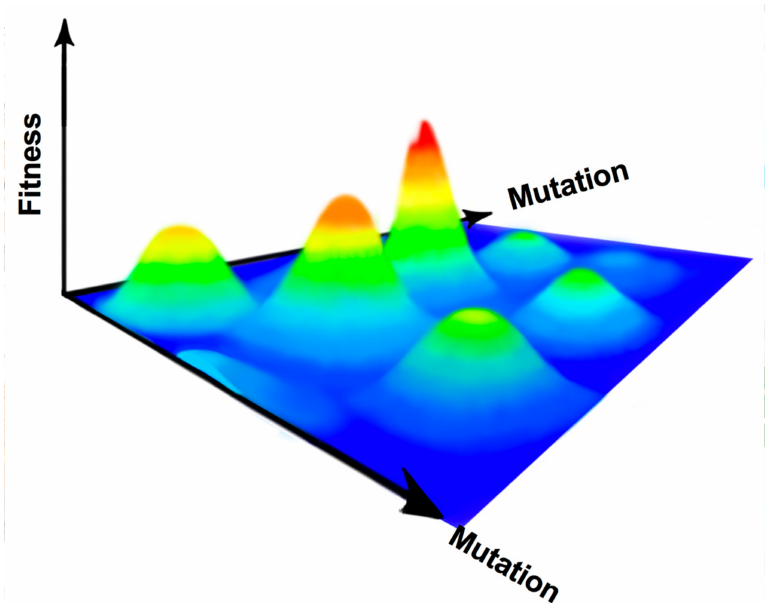
Figure 1. RNA virus mutational spectrum. As RNA viruses mutate, the sequence space is sampled to find areas of higher fitness. This space is hypothesized to be unstable, so it is best for mutation-prone RNA viruses to exist in flatter areas of this space where decreases in fitness are